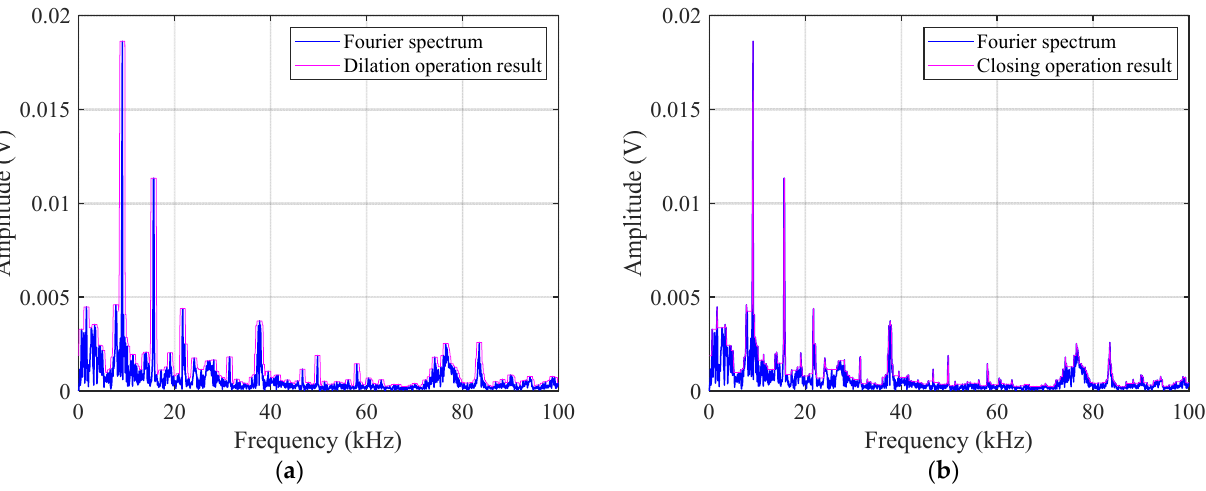
Figure 2. Closing operation process for Fourier axis: ( a ) dilation operation result; ( b ) closing operation result.